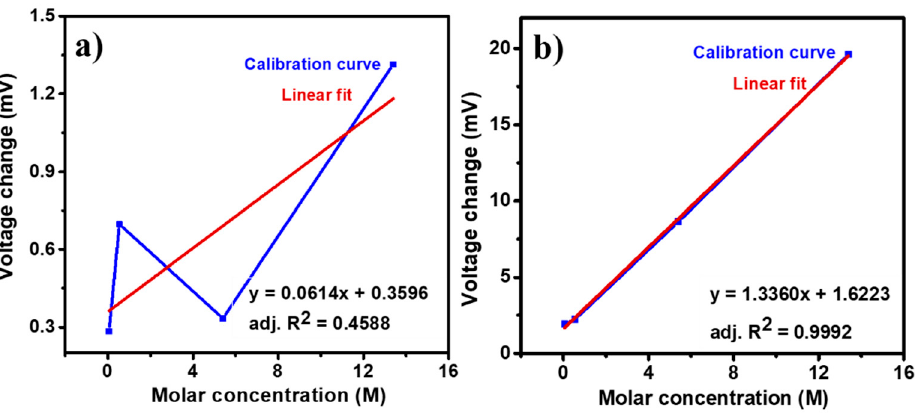
Figure 8. Calibration curve: variation of voltage changes with molar concentration of ammonium solution and linear fit to the voltage change for PVP capped Ag-NPs synthesized by using ( a ) cold and ( b ) polyol synthesis methods.